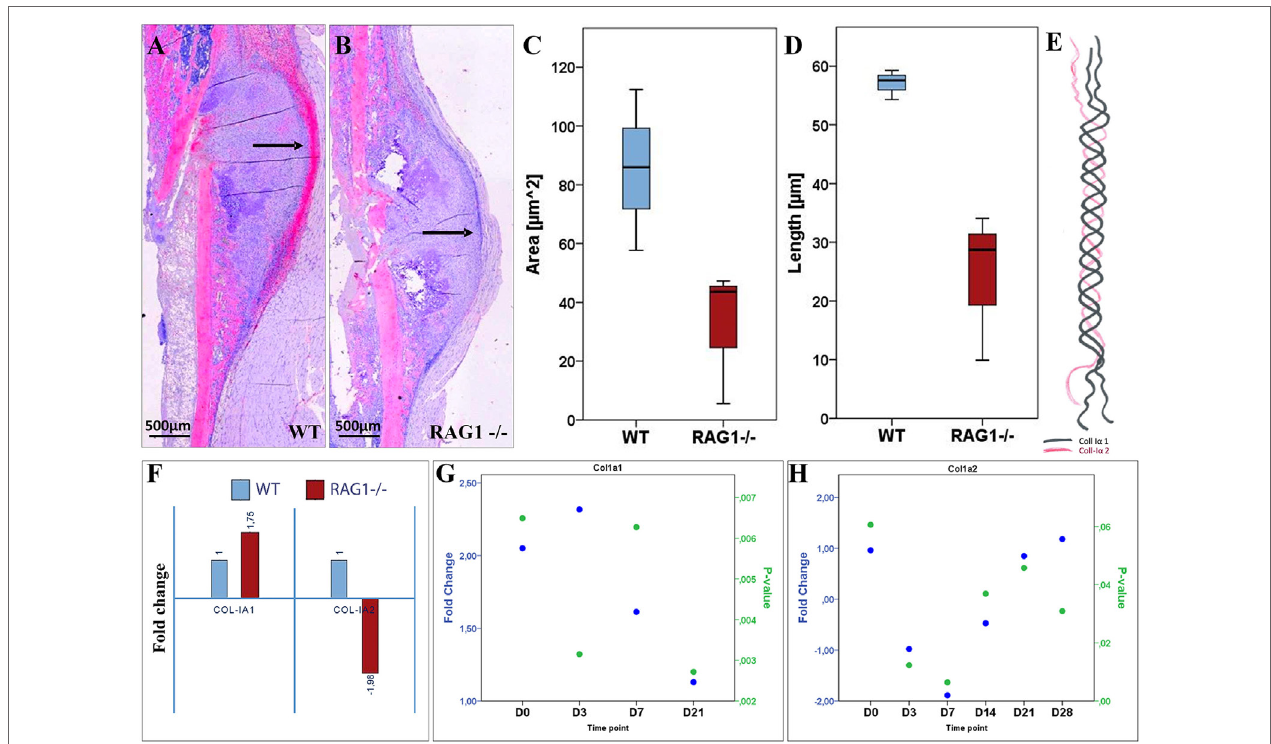
FigUre 5 | collagen type i (coli) deposition and expression pattern are considerably altered in fracture healing when mature T and B cells are absent . (a) Histological staining of ColI (2.5 × overview) shows higher signal intensity (indicated by black arrows) on the periosteal surface and the callus outer borders in the wild-type (WT) at day 7 (D7). (B) Lack of signal location at the callus outer border in the recombination activating gene 1 homozygous knockout (RAG1 − / − ) at D7 with general lower signal intensity. Compared to the RAG1 − / − , larger ColI-positive area in the WT (c) and longer surface in the WT (D) are detected. (e) ColI composition: two subunits of ColI α 1 and one subunit of ColI α 2 form the typical ColI triple helix. (F) The expression of the ColI subunits I α 1 and I α 2 at D7 shows a 1.75-fold increase in ColI α 1, while the expression of ColI α 2 was decreased by 2. Changed expression patterns for ColI α 1 (g) and ColI α 2 (h) were observed throughout the observed healing period of 28 days.